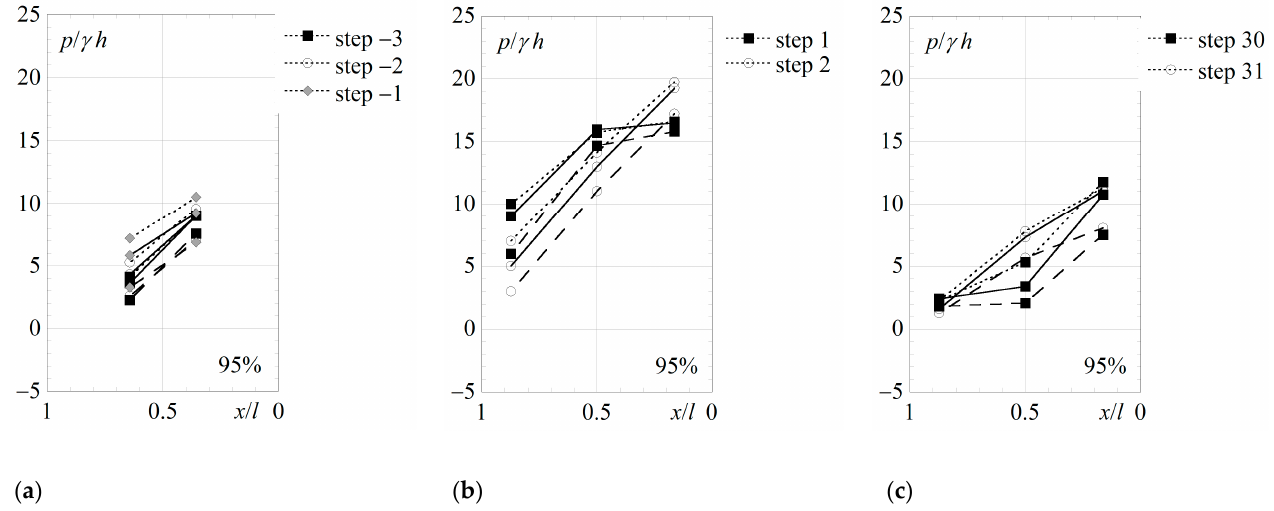
Figure 5. Dimensionless 95th percentile pressures p /( γ h ) on the horizontal step faces for the 50 ◦ to 30 ◦ slope reduction: ( a ) upstream of the slope reduction, ( b ) just downstream, and ( c ) “far” downstream; d c // h = (—) 2.6, (—) 3.8, and ( ··· ) 4.6.